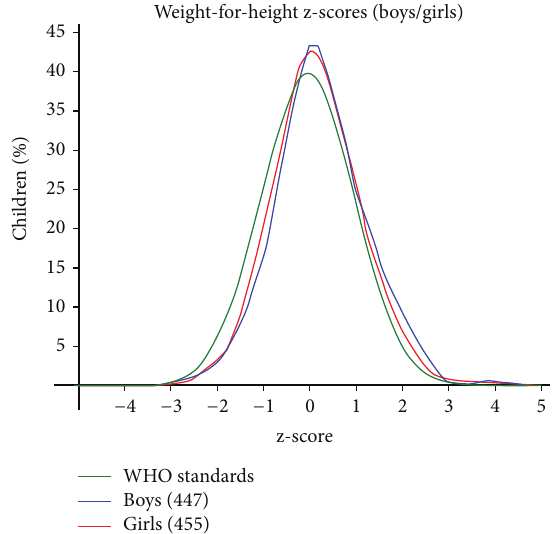
Figure 1: The graph of the normal distribution of weight for height in studied children in Salmas (mean ± SD = 0.21 ± 0.94 ).